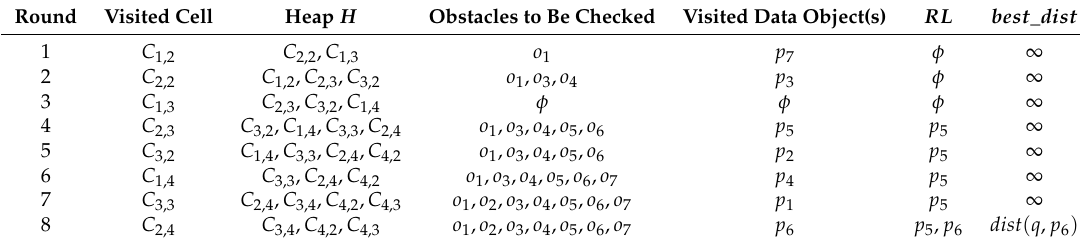
Table 2. The example steps of the baseline algorithm.